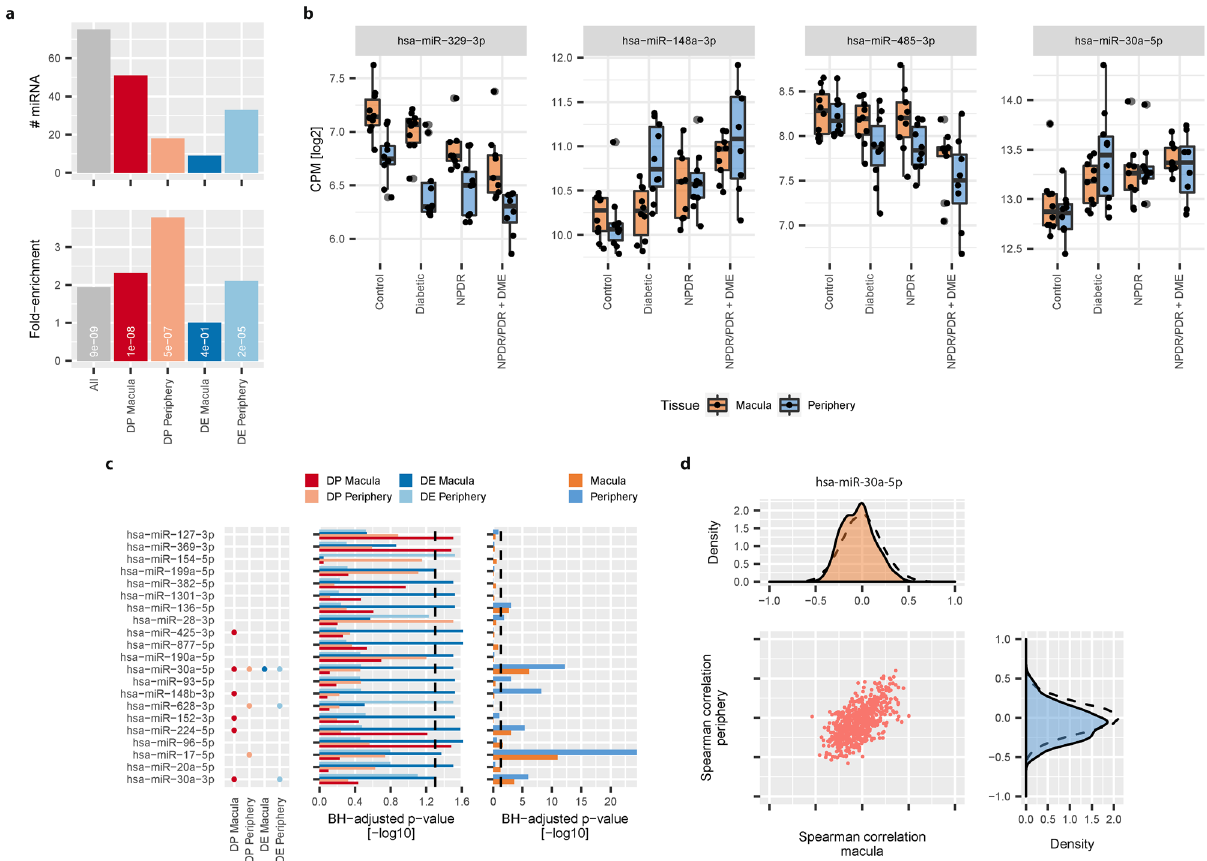
Figure 5. Integrated analysis of miRNA and mRNA expression: ( a ) Number of miRNA in all identified disease- associated transcripts (upper panel, gray bar) or in each group of identified disease-associated transcripts. Lower panel shows relative enrichment (observed vs expected) of miRNA in each of the defined disease-associated groups. White labels correspond to BH-corrected p values of a hypergeometric test. ( b ) Log2 CPM expression of miRNA identified in all four groups of disease-associated transcripts (black dots). Black line denotes median log2 CPM. Boxplot lower and upper hinges correspond to the first and third quartiles respectively. Whiskers extend to the largest expression value no further than 1.5 interquartile range from the hinge. Outliers are shown in transparent gray. ( c ) Barplot of BH-adjusted p values [− log10] of miRNA target enrichment analysis for each of the four identified groups of disease-associated genes (left panel). Only miRNA with significant enrichment of their target genes in any of the four defined groups of disease-associated mRNA are shown. Dashed line indicates the level of significance chosen (BH-adjusted p value < 0.05). Right panel shows BH-adjusted p values [− log10] of a Kolmogorov–Smirnov test for negative skew in correlation between miRNA and target mRNA expression (Orange: Macula samples, Blue: Periphery samples). ( d ) Distribution of Spearman correlation values between miR-30a-5p and its putative target genes in either macula (upper panel) or periphery samples (right panel). Dashed line corresponds to background distribution of 100.000 correlations between non-associated miRNA/mRNA pairs. Middle panel represents the scatter plot for individual Spearman correlation values between miR-30a-5p and its